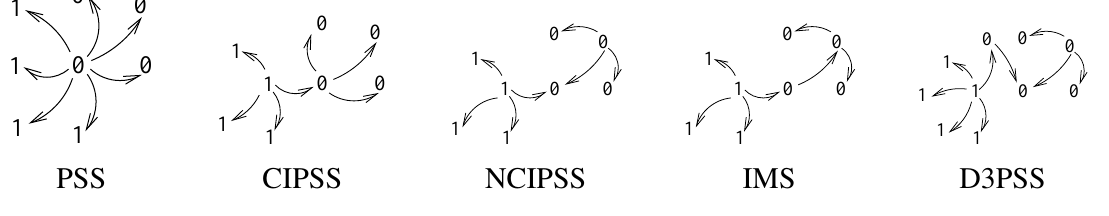
Figure 1. Networks